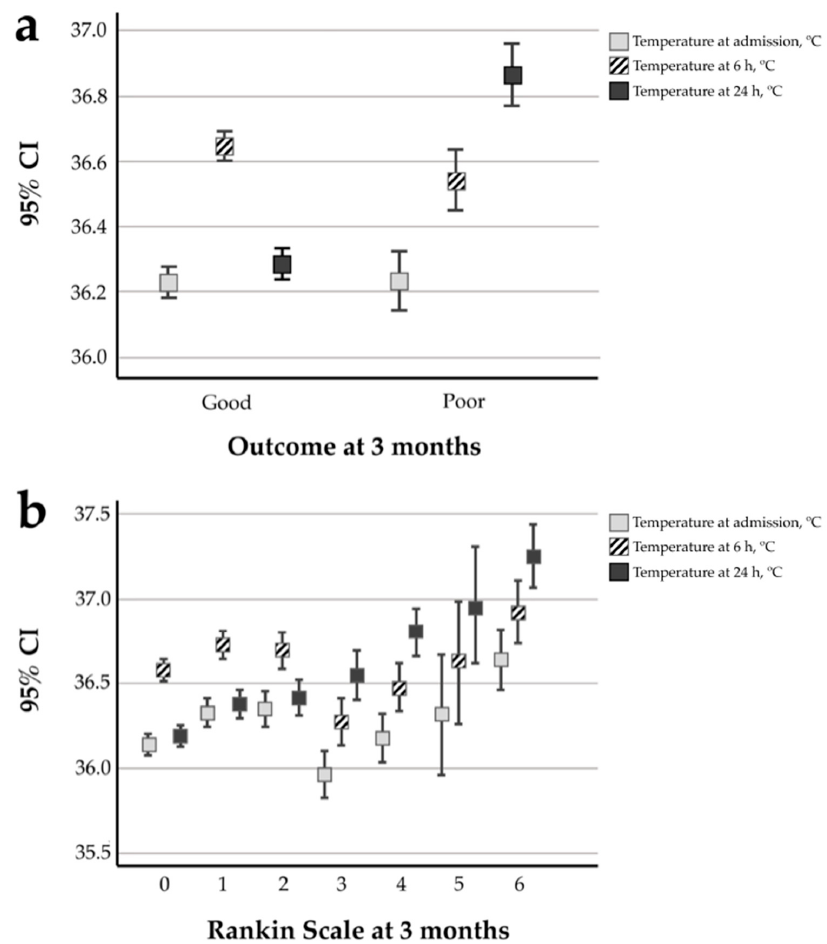
Figure 2. Evaluation of functional outcomes at 3 months. ( a ) Temperatures at admission and 6 and 24 h in relation to patient outcomes. ( b ) Temperatures at admission and 6 and 24 h in relation to modified Rankin Scale scores at 3 months.